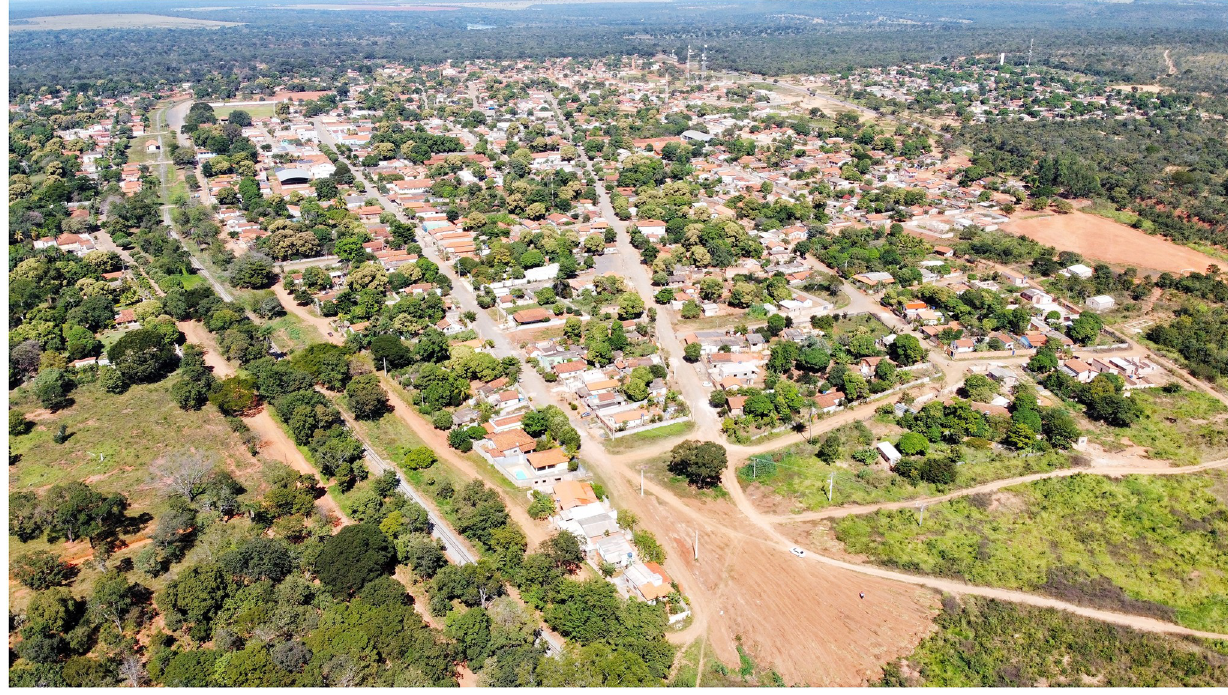
Fig 2. Aerial view of the urban area of Lassance, Minas Gerais, Brazil.